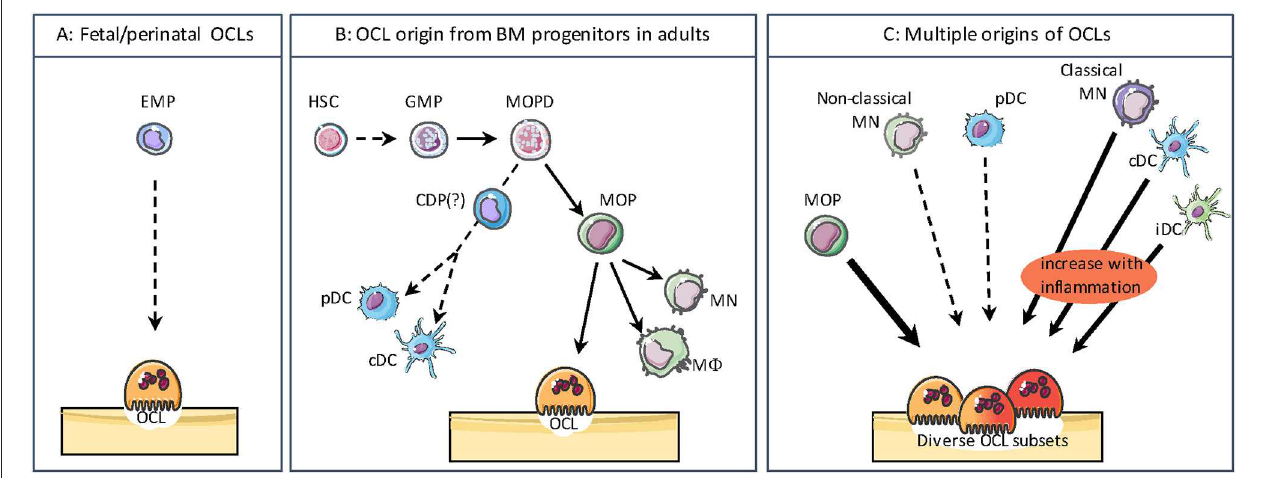
FIGURE 2 | The different origins of osteoclasts. (A) During the embryonic and postnatal period, OCLs differentiate from the embryonic erythro-myeloid progenitor (EMP) lineage. (B) In adults, bone marrow progenitors for osteoclasts (OCLs) and other monocytic cells such as monocytes (MN), macrophages (M 8 ), as well as conventional/classical dendritic cells (cDCs) and plasmacytoid DCs (pDCs) share common progenitors downstream of the granulocyte/M 8 progenitor (GMP). HSC, Hematopoietic Stem Cell; MOPD, M 8 /OCL/DC progenitor; CDP, common DC progenitor; MOP, M 8 /OC progenitor. The divergence of CDP from MODP is not clearly evidenced. (C) OCLs have multiple origins depending on their environment. Beside their origin from MOP, in pathological conditions OCLs can also arise from classical MNs, cDCs and inflammatory DCs (iDC). OCLs differentiation from non-classical and pDCs is much less efficient. These different sources of OCLs result in a heterogeneity as observed for other monocytic